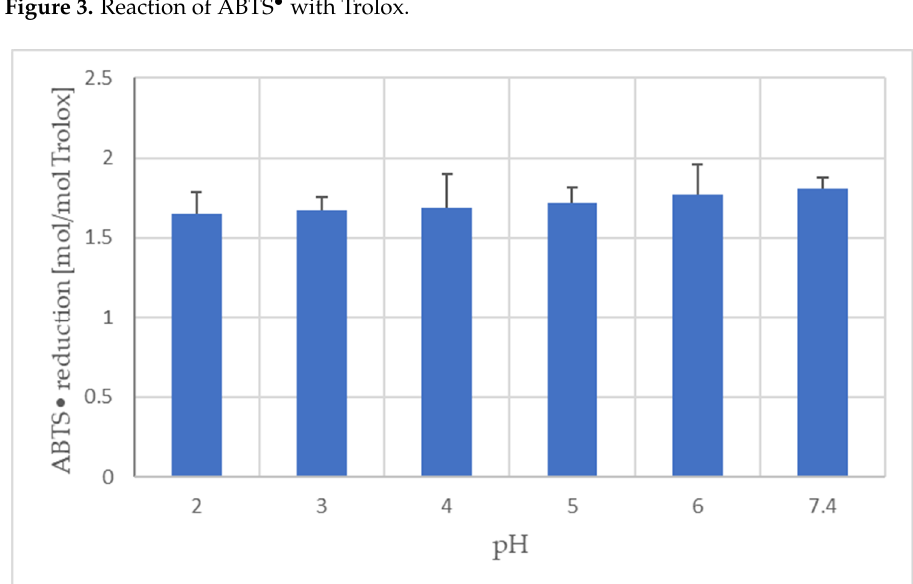
Figure 3. Reaction of ABTS • with Trolox.